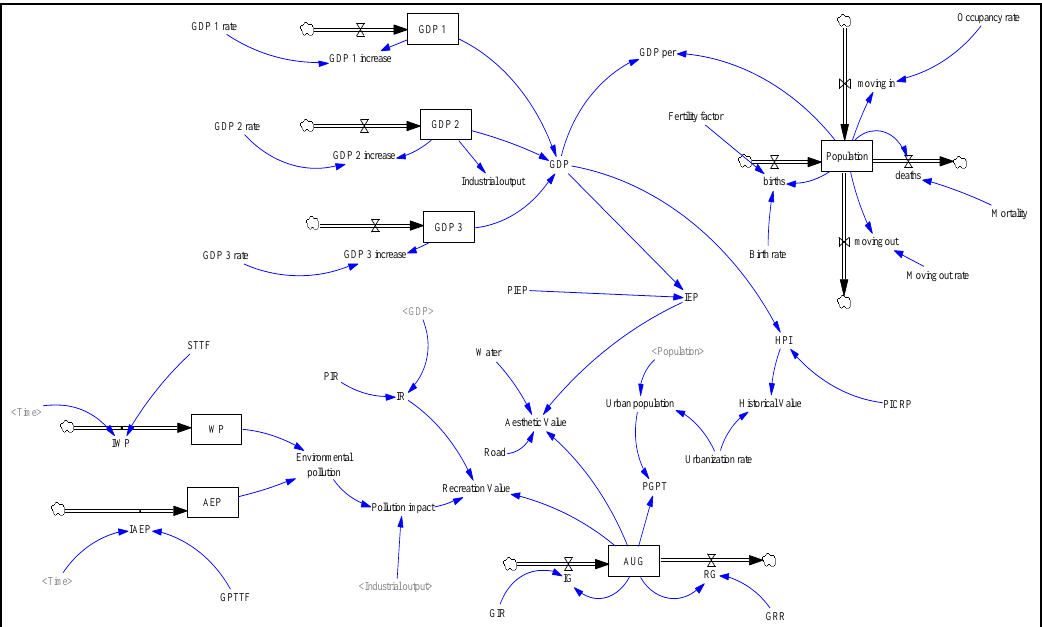
Figure 3. Flow chat of the total system.